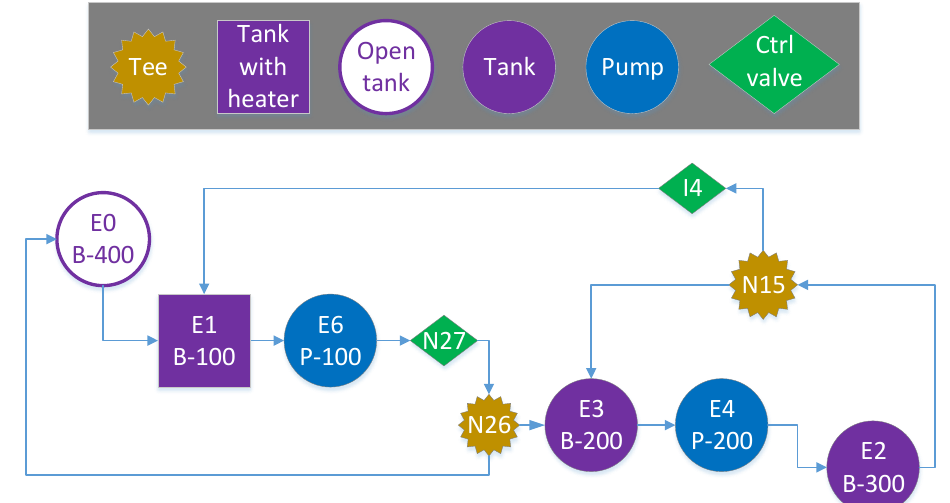
Figure 11. The result of processing the graph in Figure 10 with the algorithm in Figure 3. All binary valves are removed.